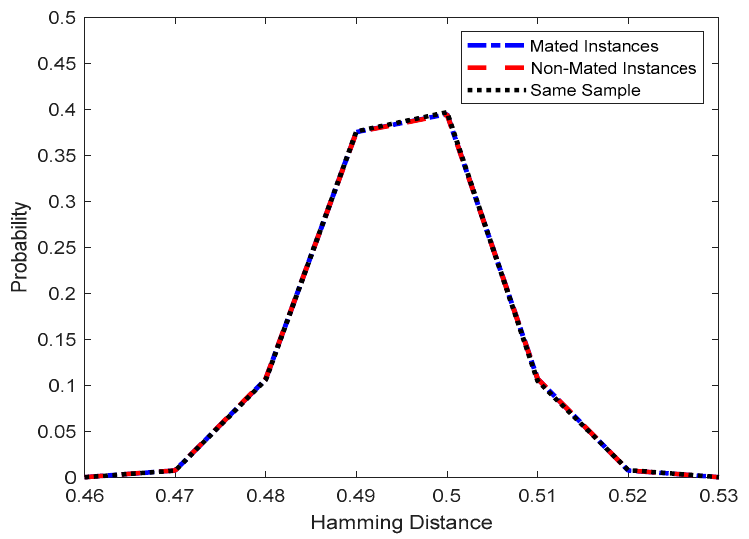
Figure 6. Revocability and unlinkability evaluation for the LFW database with Classic McEliece mceliece6688128 parameter set.